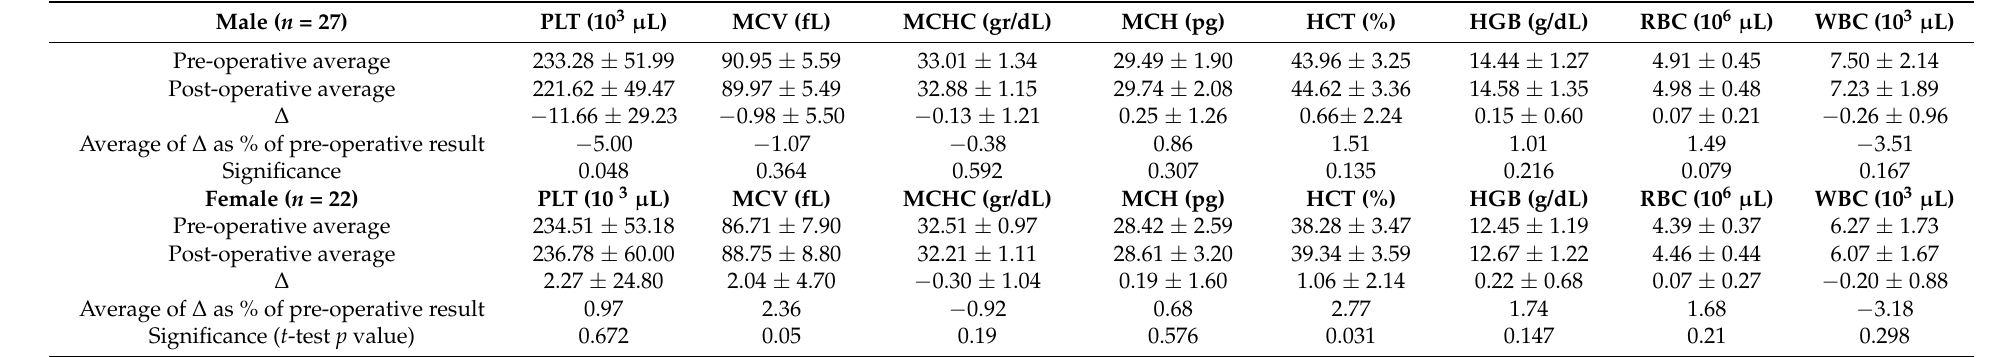
Table 3. Change between pre-operative and post-operative CBC parameters stratified by gender.